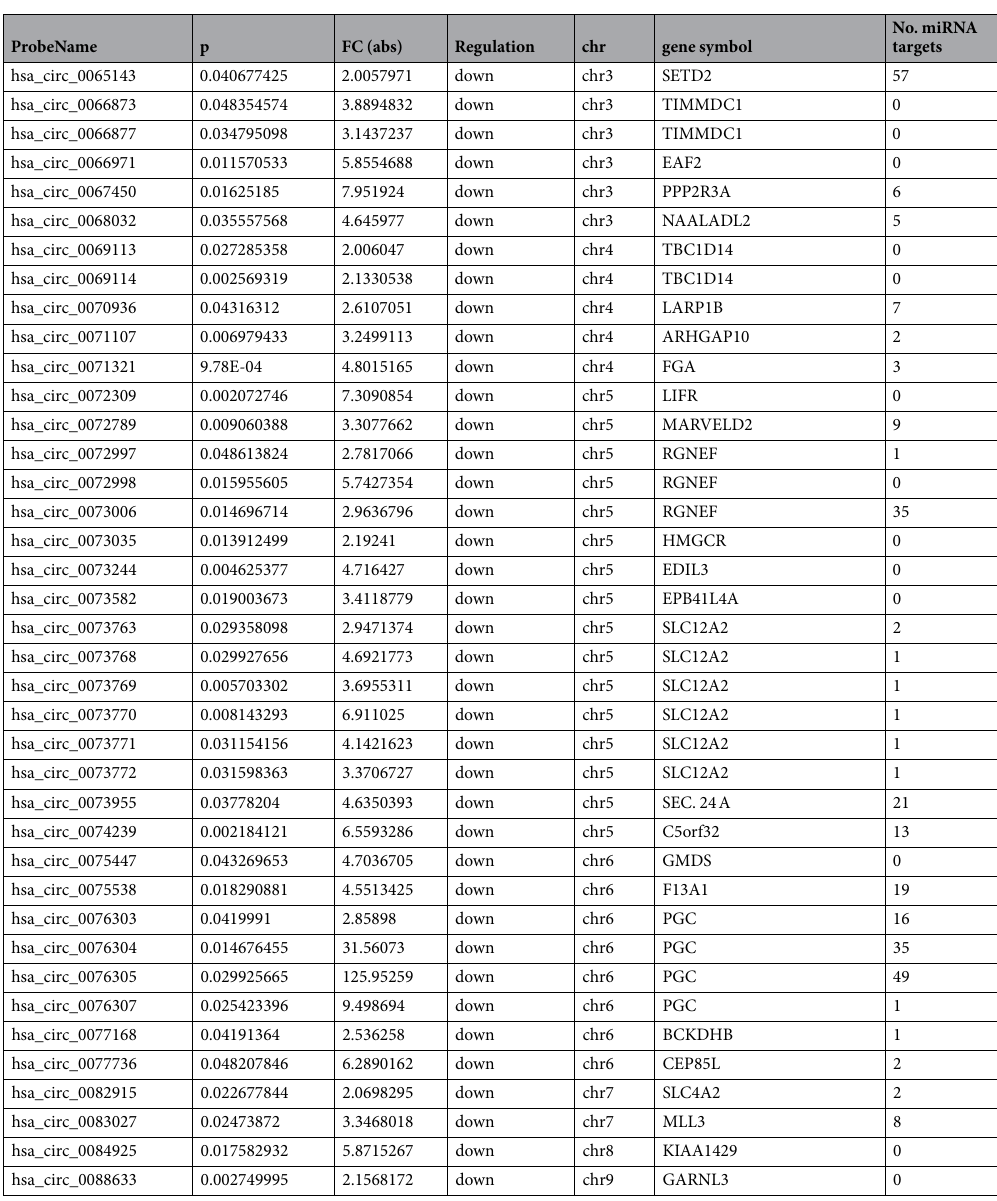
Table 3. The numbers of potential targeted miRNAs of the differentially expressed